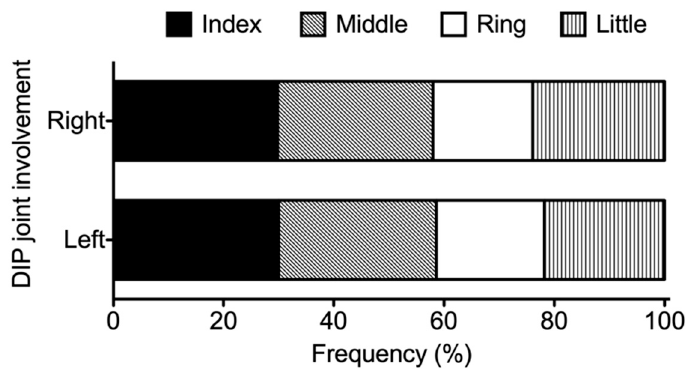
Figure 2. The distribution of distal interphalangeal (DIP) joint involvement in each finger in the right hand (upper) and the left hand (lower) in rheumatoid arthritis (RA) patients with symptomatic DIP joint involvement. Symptomatic DIP joint involvement was defined by the presence of tenderness and/or swelling from the second through fifth DIP joints. The frequency of DIP joint involvement of the index finger (second DIP joint), the middle finger (third DIP joint), the ring finger (fourth DIP joint), and the little finger (fifth DIP joint) were plotted horizontally as percentages.